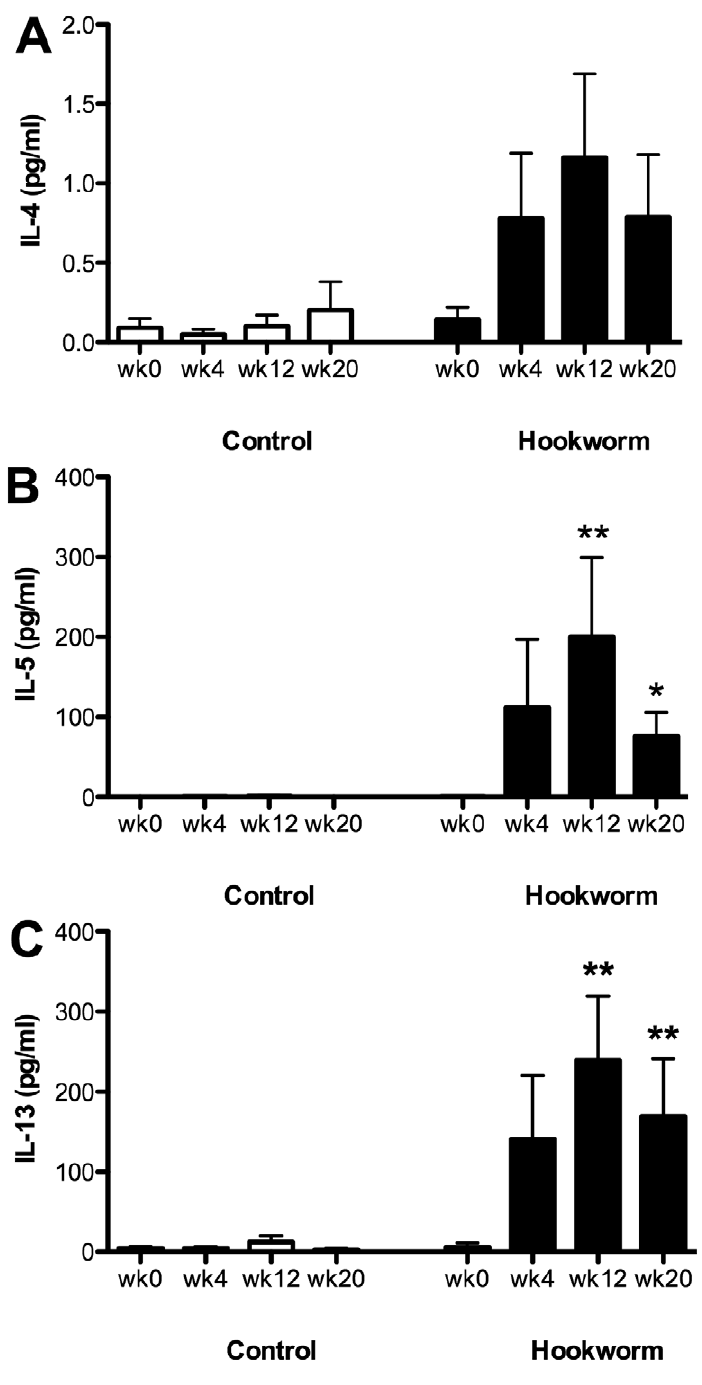
Figure 2. Systemic production of hookworm-specific cytokines. Peripheral blood mononuclear cells were harvested from subjects in Trial 1 and cultured for 120 h at 37 u C in either tissue culture medium (MED) or MED containing 10 m g/ml Necator americanus ES products (NaES). Cell supernatants were removed and levels of IL-4 (A), IL-5 (B) and IL-13 (C) determined using a Cytometric Bead Array. Cytokine levels from PBMCs stimulated with just MED alone were subtracted from those stimulated with NaES. Data were analysed by Kruskal-Wallis non-parametric ANOVA, comparing time points at weeks 4, 12 and 20 to week 0 within each group.